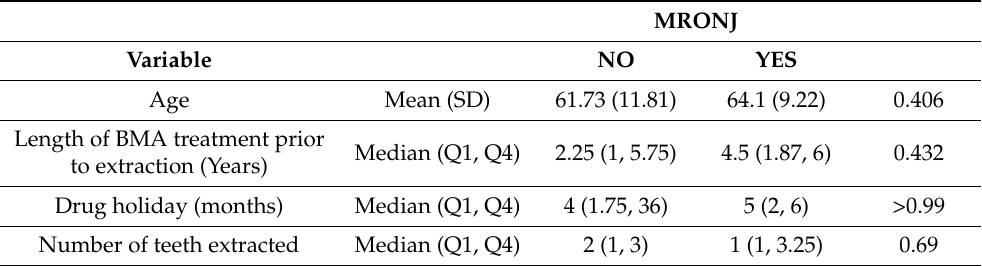
Table 4. Relationship between numerical variables for the development of MRONJ in 103 extraction